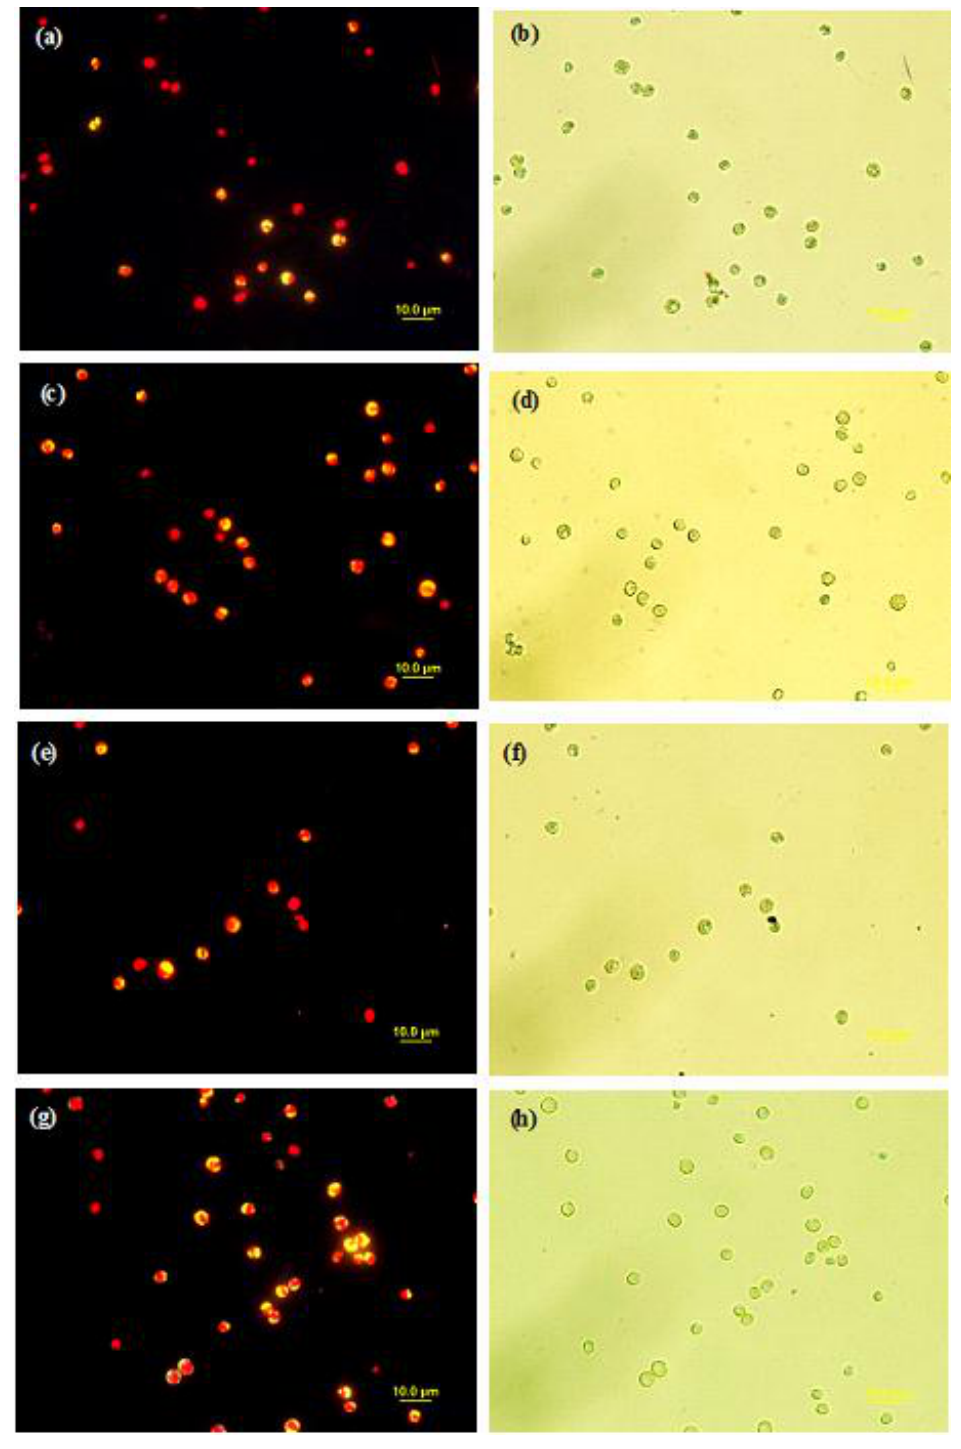
Figure 7. Fluorescence ( a , c , e , and g ) and light microscopy ( b , d , f, and h ) images of C. pacifica after laser radiation. Bar = 10 ì m.